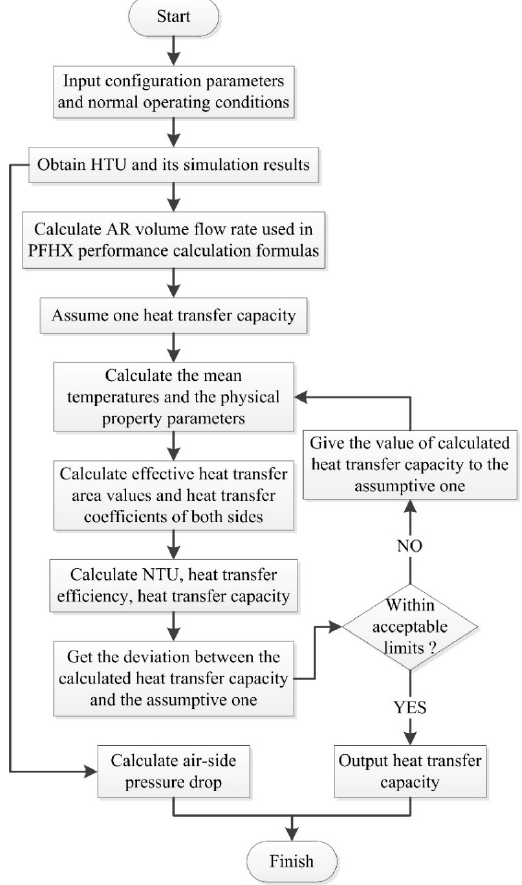
Figure 7. Flowchart of AR performance calculation